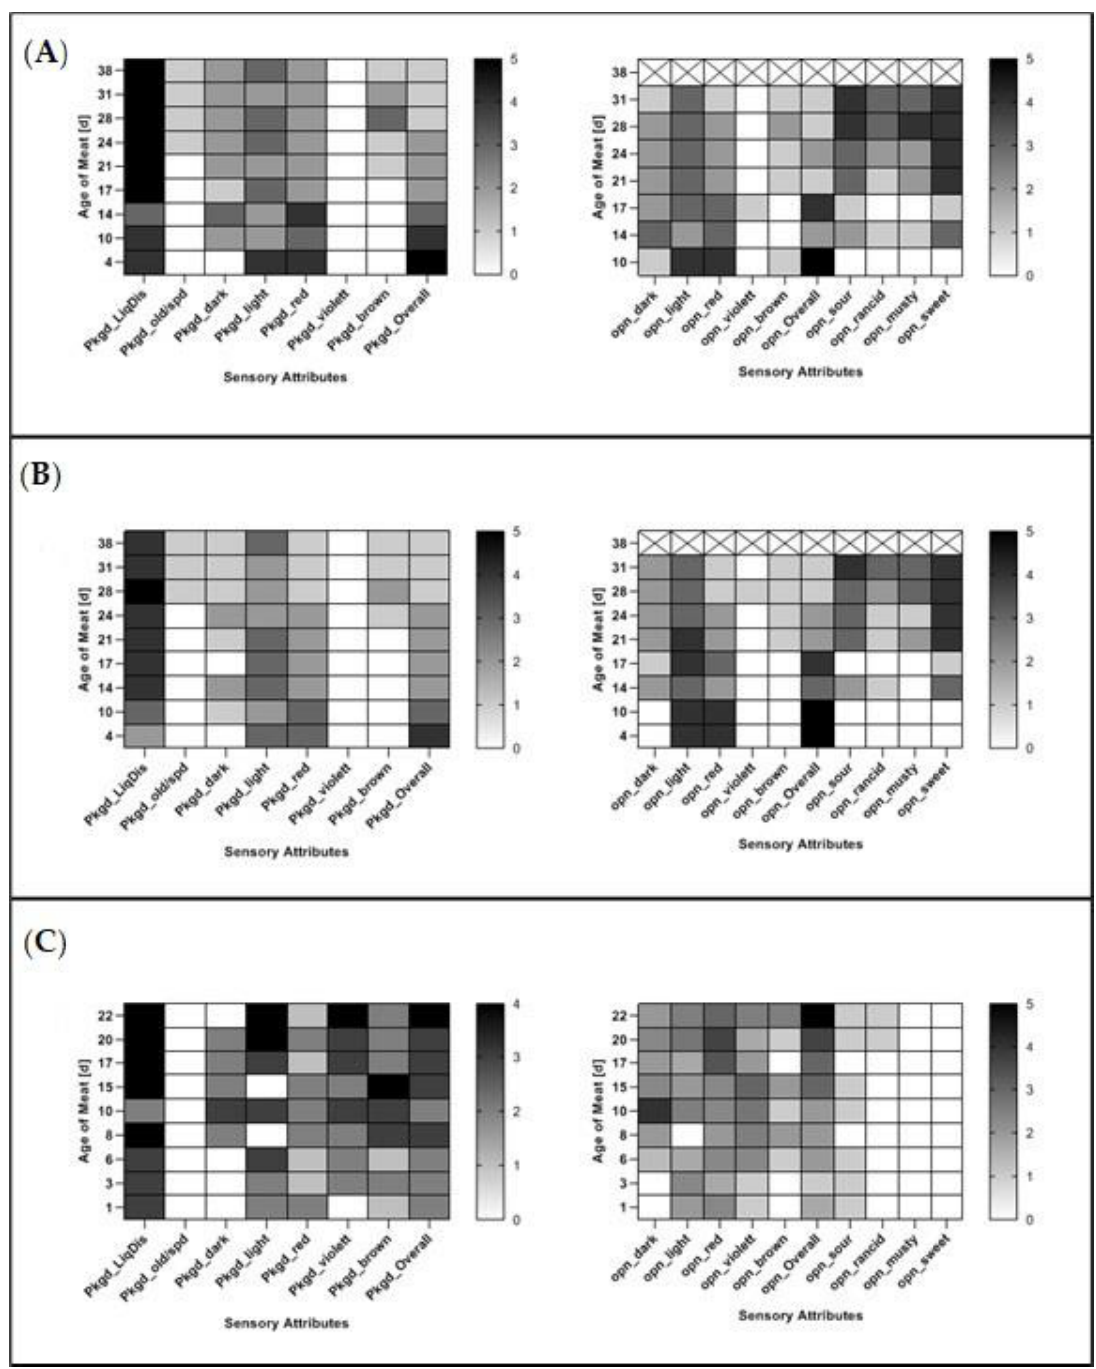
Figure A1. Average sensory evaluation of packaged and opened pork loin (PL) in: ( A ) BioMAP; ( B ) MAP over a meat age of 38 days; and ( C ) VSP over a meat age of 22 days.